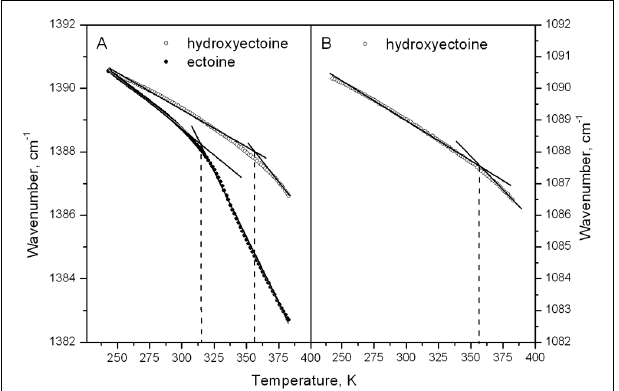
FIGURE 12 |Temperature dependence of the frequency vibration at 1382–1392 cm –1 in dry ectoine and hydroxyectoine (A) and at 1082–1092 cm –1 in dry hydroxyectoine (B)